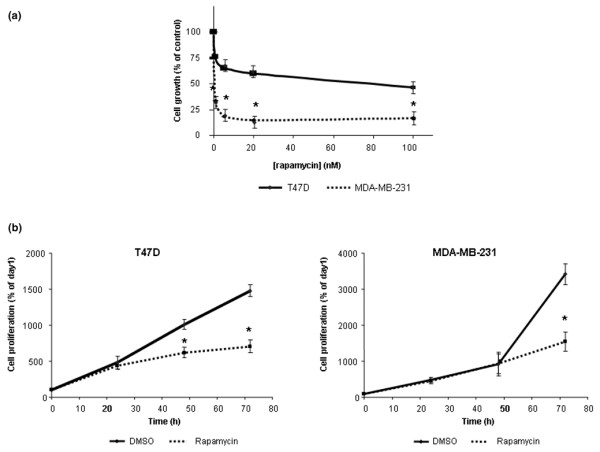
Effect of rapamycin on cell growth. (a) The dose-effect curve of rapamycin on cell growth. The breast cancer cell lines T47D and MDA-MB-231 were treated with different concentrations of rapamycin for 72 h and the decrease in growth rate compared to control cells was assessed. (b) Time dependence of the effect of rapamycin on cell growth. The breast cancer cell lines T47D (left) and MDA-MB-231 (right) were treated with rapamycin (20 nM) for different time periods and the decrease in growth rate compared to control cells was assessed. Results are means ± standard error of the mean, with n = 3 for each treatment. *p < 0.05 between the two conditions.